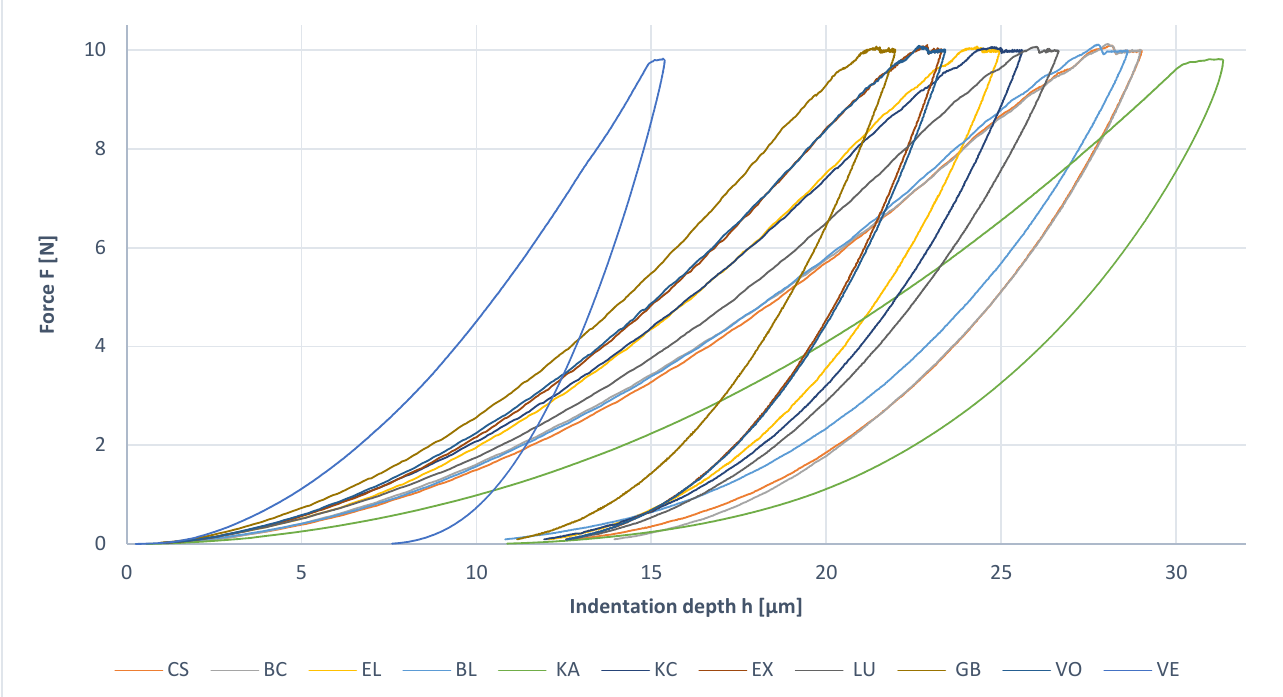
Figure 2. Force – indentation depth curves of the tested composite materials. Figure 2. Force–indentation depth curves of the tested composite materials. The mean Martens hardness (H M ) ranged from 410.8 ± 55.8 N/mm 2 (KA) to 1143.4 ± 124.7 N/mm 2 (VE). The ANOVA showed significant ( p ≤ 0.001) differences between the results (Table 2). The residual indentation depth (h r ) was between 13.9 ± 0.7 µm (VE) and 23.0 ± 1.4 µm (KA), with significant differences between the results (ANOVA: p ≤ 0.001). The indentation hardness (H IT ) varied between 666.5 ± 88.2 N/mm 2 (KA) and 1834.2 ± 198.0 N/mm 2 (VE). The ANOVA confirmed significant ( p ≤ 0.001) differences between the re- sults. The indentation modulus (E IT ) ranged from 8.8 ± 1.4 kN/mm 2 (KA) to 25.3 ± 3.0 kN/mm 2 (VE), with significant differences between the results (ANOVA: p ≤ 0.001). The mean elastic part of indentation (η IT ) varied between 40.2 ± 0.5% (VO) and 50.4 ± 4.3% (LU) (Figure 3). The ANOVA confirmed significant differences between the mean values ( p ≤ 0.001). The indentation creep (C IT ) ranged from 3.2 ± 0.1% (VE) to 5.1 ± 0.4% (KC). The ANOVA showed significant ( p ≤ 0.001) differences between the values.